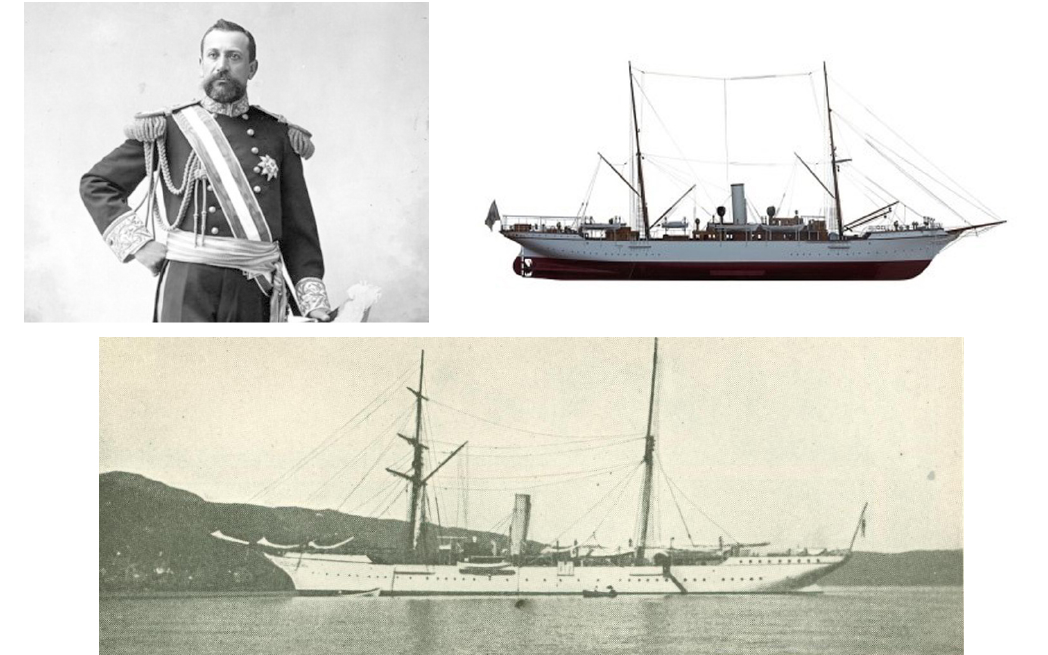
Figure 2. HMSH Prince Albert I of Monaco and his vessels the Hirondelle (top; source: http://www.institut-ocean.org/, last access: 19 March 2019) and Princesse Alice (bottom; source: http://www.digitalhistoryproject.com/2012/08/prince-albert-of-monaco-as-oceanographer.html, last access: 19 March